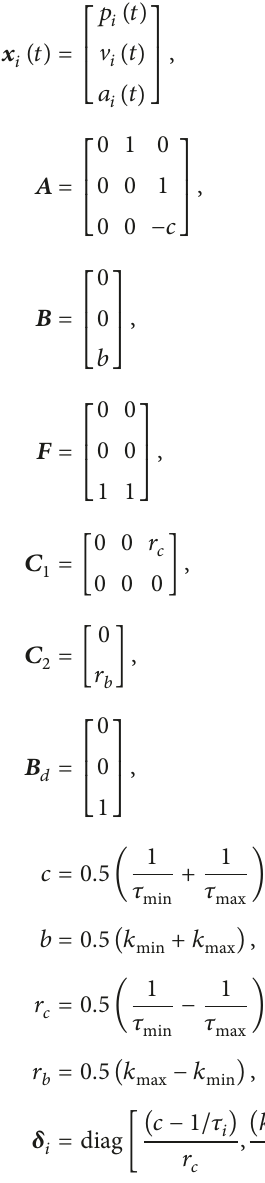
Table 1: Parameter values of vehicle model.